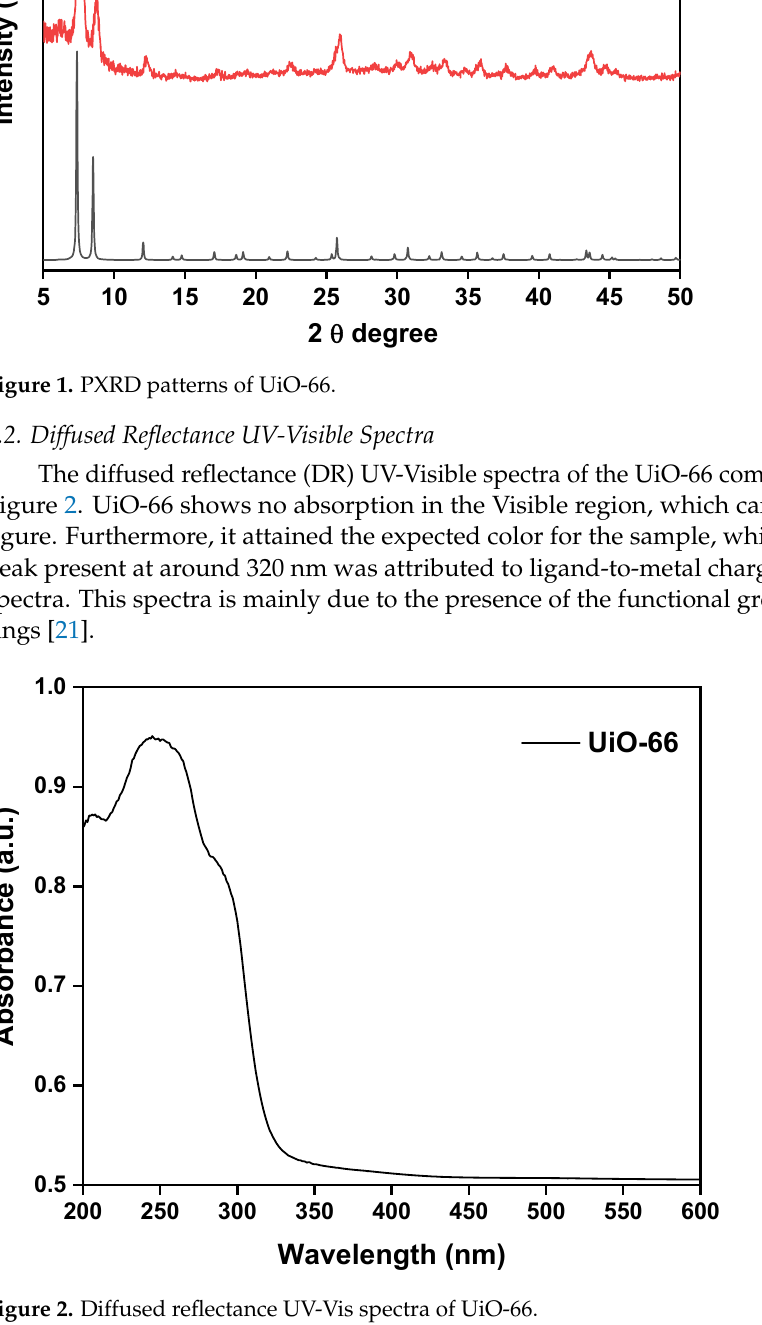
Figure 2. Diffused reflectance UV ‐ Vis spectra of UiO ‐ 66.